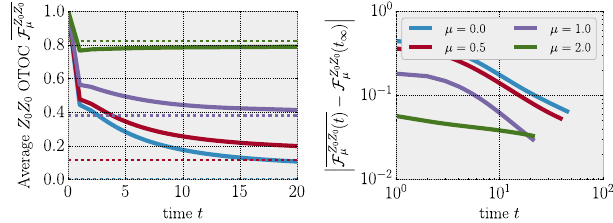
ˆ Z ˆ Z FIG. 11. Time evolution of the OTOC on site zero for chemical potentials μ ¼ 0 , 1 = 2 , 1, 2 in the random circuit model. The left-hand panel shows the OTOC approaching the saturation value predicted by Eq. (25) (dashed horizontal lines). For μ ¼ 2 the OTOC tends to the long-time value from below. The right- hand panel shows the distance from this equilibration value as a function of time. The lines for μ ¼ 0 and μ ¼ 1 = 2 are parallel, indicating that the latter also exhibits the diffusive t − 1 = 2 decay discussed in Sec.